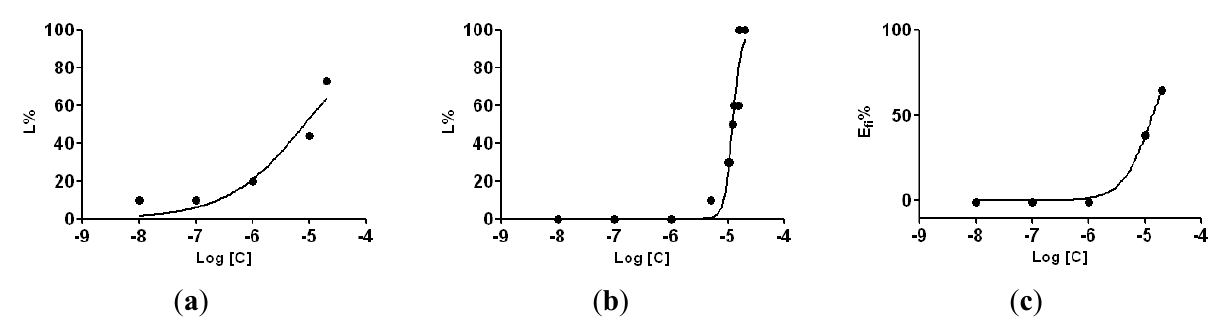
Figure 4. Dose-mortality curves for cytotoxic activity on A . salina ( a ), D . magna ( b ) and T . aestivum ( c ), exposed to compound 4e